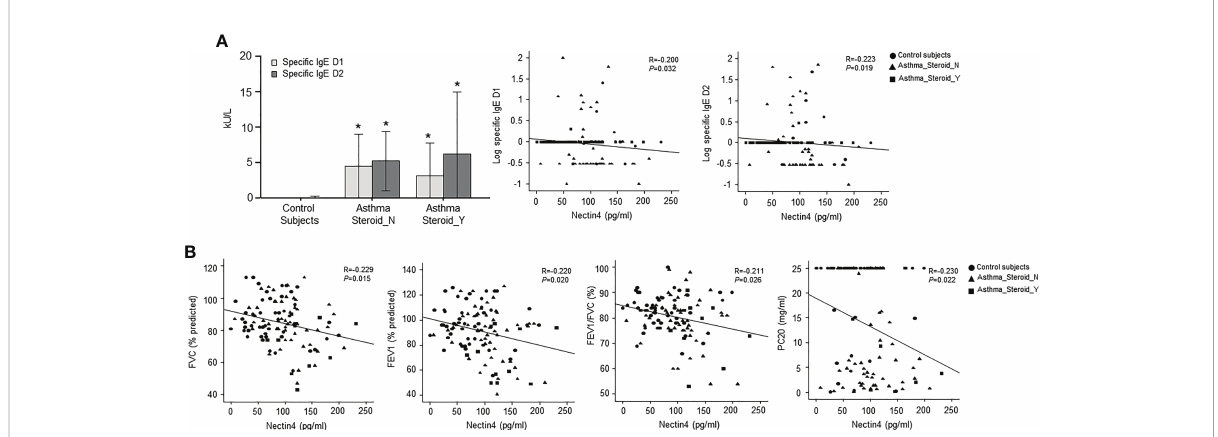
FIGURE 2 Relationship between plasma Nectin4 and clinical variables in asthma patients. (A) Speci fi c IgE D1 or speci fi c IgE D2 level for control subjects, steroid not treated group, and steroid treatment group for exacerbation. *p<0.05, control vs. asthma patients. (B) Correlation of plasma Nectin4 and clinical variables including FVC% predicted, FEV1% predicted, FEV1/FVC%, and PC20. * p<0.05, Spearman ’ s rank